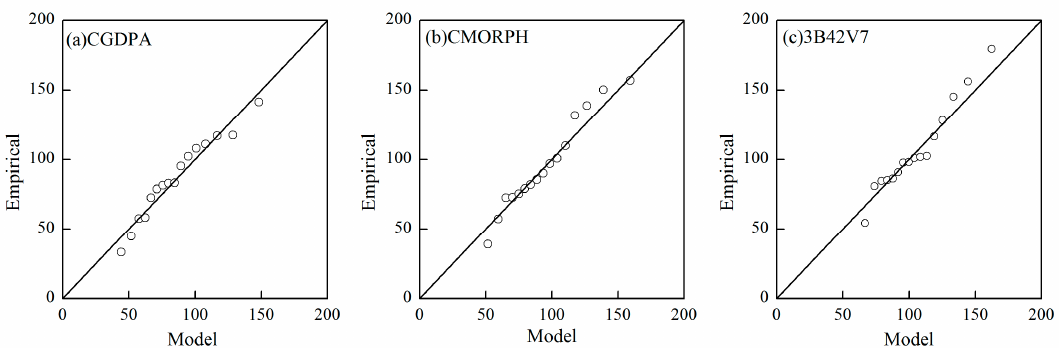
Figure 11. Quantile-Quantile plot for ( a ) CGDPA; ( b ) CMORPH; and ( c ) 3B42V7.